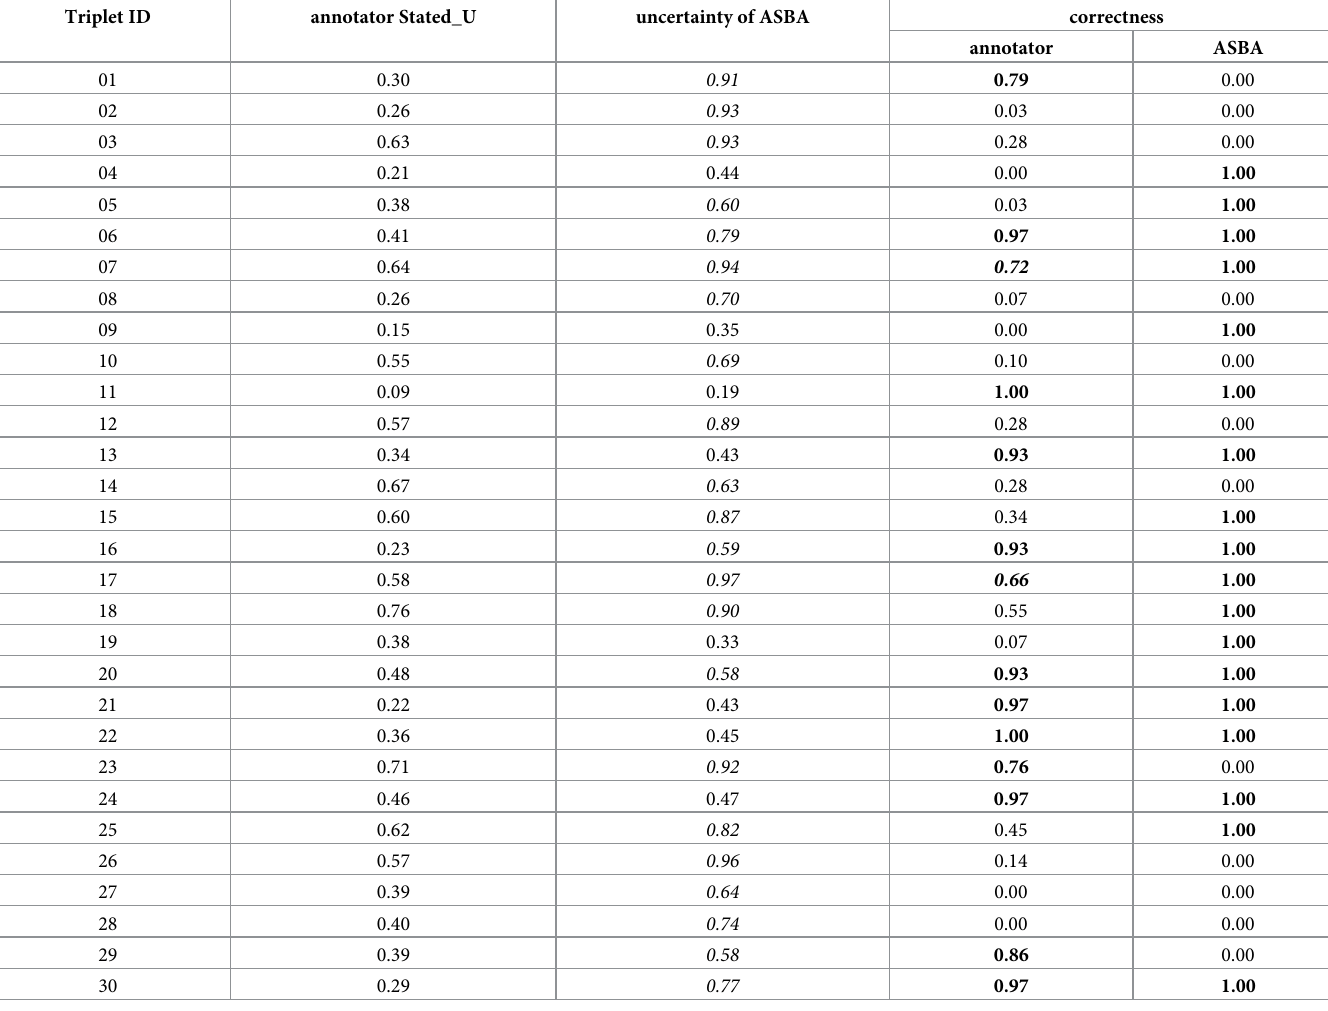
Table 8. Juxtaposition of stated uncertainty and correctness of the annotators and the Artificial Similarity-Based Annotator (ASBA) for each triplet.